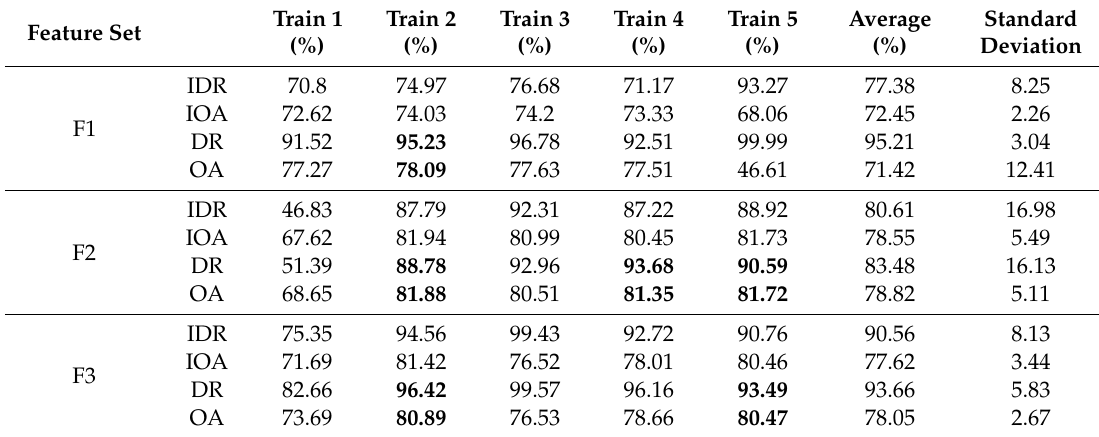
Table 6. Extraction accuracy of three feature